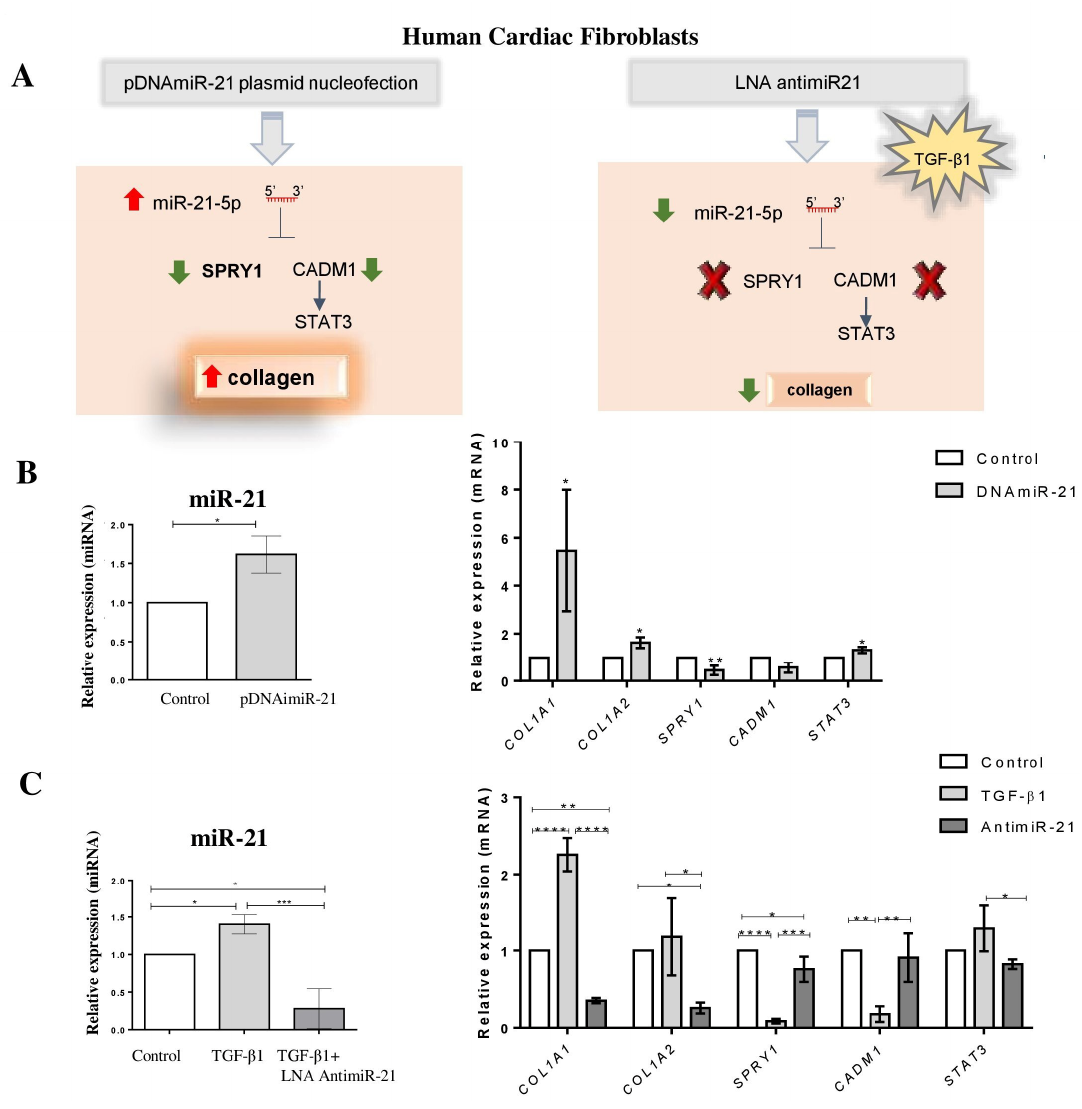
Figure 5. MiR-21 mediates fibrogenic activation in human cardiac fibroblasts. ( A ) Schematic representation of miR-21 overexpression by nucleofection of human cardiac fibroblasts with the expression vector and miR-21 inhibition by LNA anti-miR-21. ( B ) MiR-21, COL1A1 , COL1A2, SPRY1 , CADM1, and STAT3 expression levels 48h after nucleofection with miR-21 expression vector (pDNAmiR-21), measured by RT-qPCR (Fold Change to non-stimulated control). miRNA was normalized to miR-423-3p, and mRNAs were normalized to HPRT/GAPDH . ( C ) MiR-21, COL1A1, COL1A2, SPRY1, CADM1, and STAT3 expression levels after TGF β 1 stimulation or treated with LNA-anti-miR-21 for 24 h, measured by RT-qPCR (Fold Change to non-stimulated control). miRNA was normalized to miR-423-3p, and mRNAs were normalized to HPRT/GAPDH . Results are expressed as mean ± SEM of three independent experiments. * p < 0.05, ** p < 0.01, *** p < 0.001, **** p < 0.000.1 Student’s t -test.